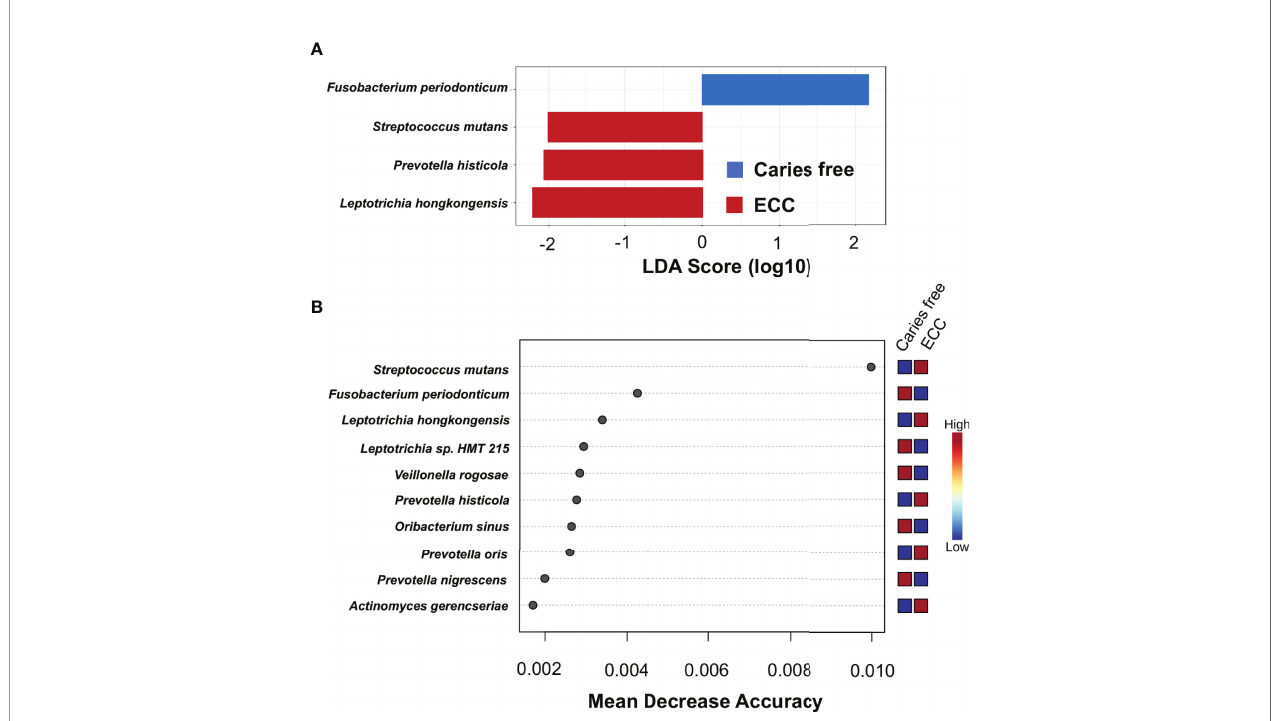
FIGURE 5 | Taxa at genus level differently enriched in ECC and caries-free children. (A) Linear discriminant analysis (LDA) effect size (LEfSe) method was performed to compare taxa between ECC and caries-free children. The bar plot lists the signi fi cantly differential taxa based on effect size (LDA score log 10 >2.0 and FDR <0.1). (B) Random forest identi fi ed important features at the species level that were differently enriched among ECC and caries-free children. Red indicates a higher abundance in ECC, whereas blue indicates a higher abundance in caries-free